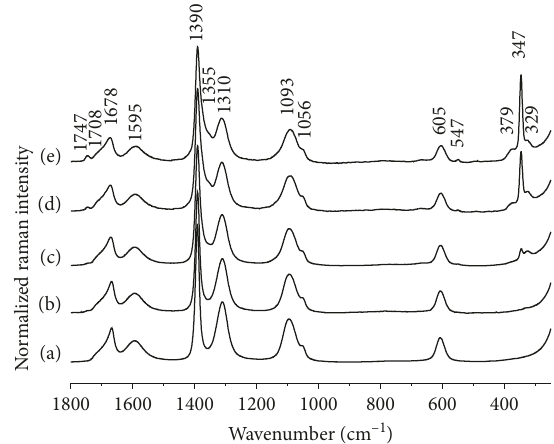
Figure 1: Raman spectra of liquid FA and its solutions containing GaCl 3 at different molalities: (a) solvent; (b) 0.1; (c) 0.5; (d) 1.0; (e)